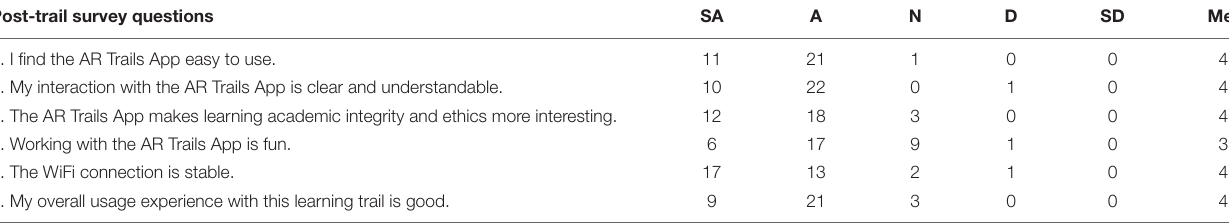
TABLE 1 | Post-trail survey results.